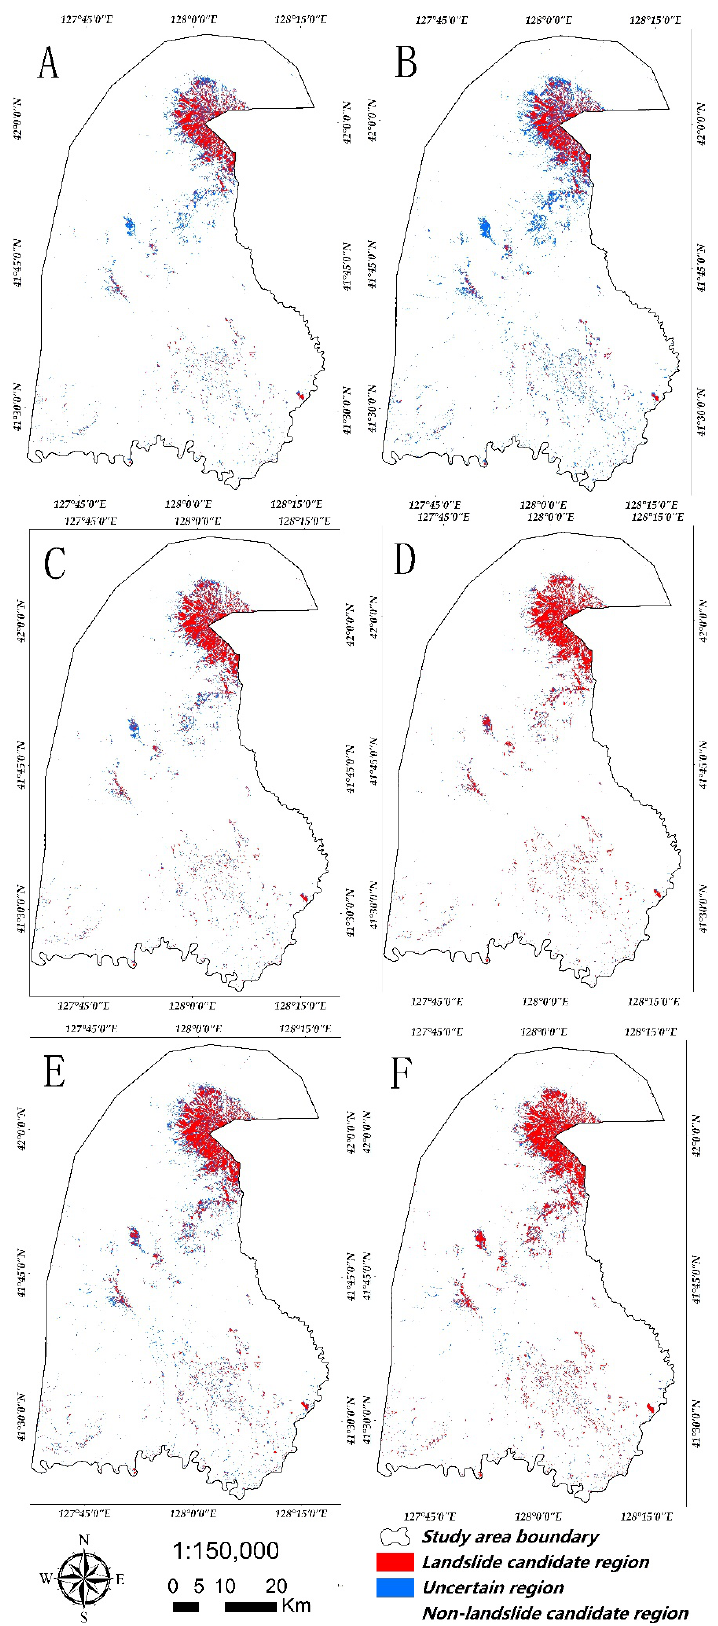
Figure 5. Thresholding test results. ( A ) T and ∆ T as 2 and 1.5; ( B ) T and ∆ T as 1.5 and 2; ( C ) T and ∆ T as 2 and 1; ( D ) T and ∆ T as 2 and 0.5; ( E ) T and ∆ T as 1.5 and 1; ( F ) T and ∆ T as 1.5 and 0.5.